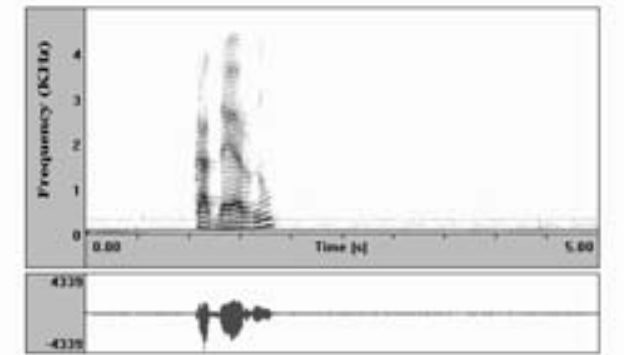
Figura 1b. TrŒs emissıes da palavra caderno, realizadas pelo sujeito